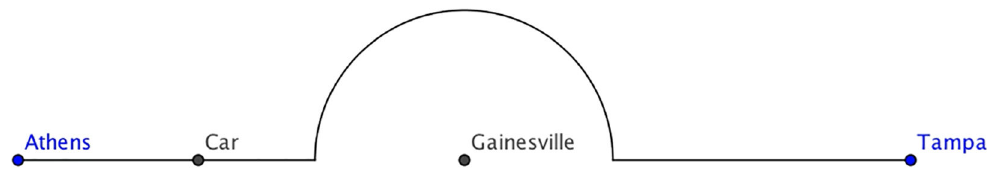
Figure 8. Moore’s (2016) Gainesville